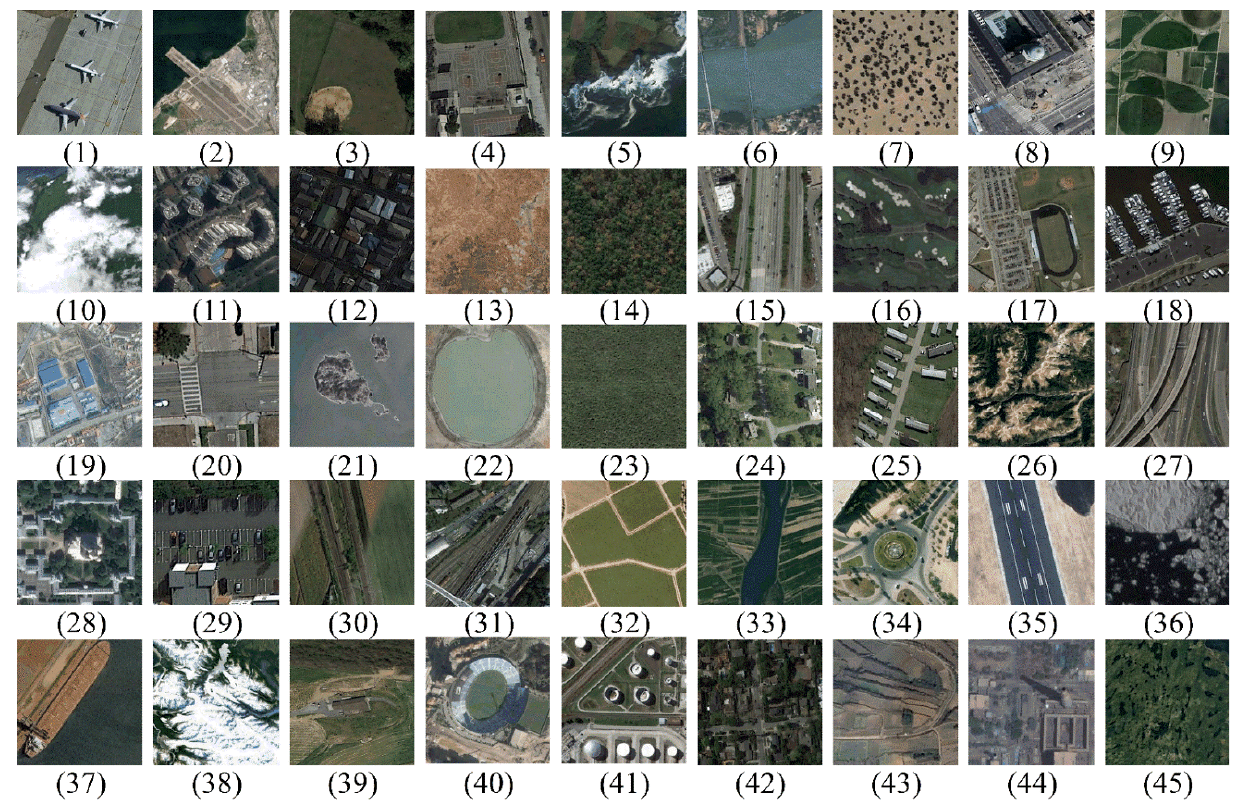
Figure 4. Example images of NWPU ‐ RESISC45 dataset.